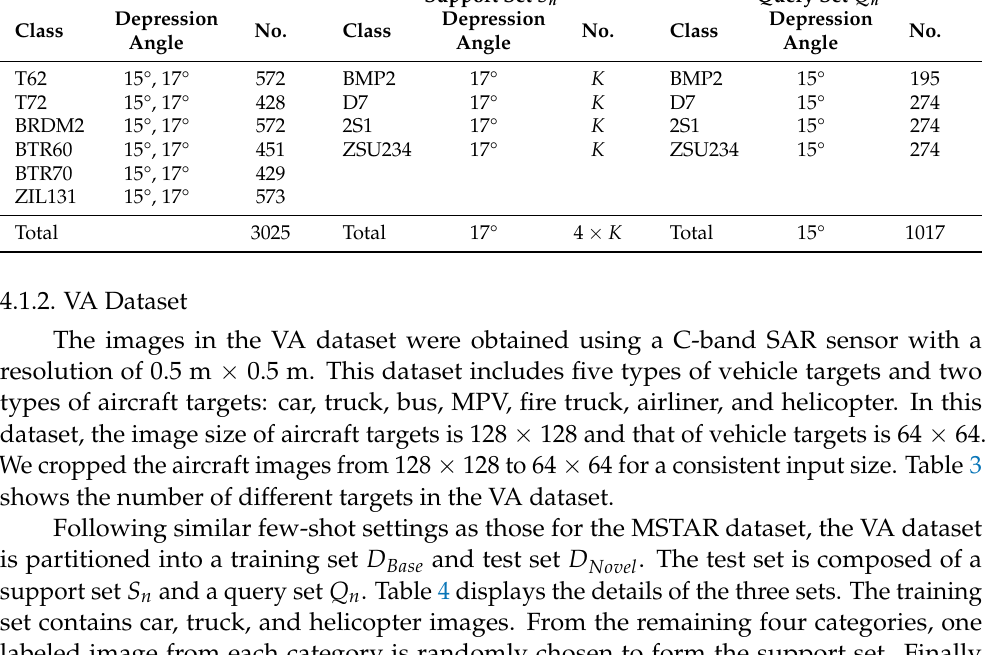
Table 2. The number of images in the training, support, and query sets of the MSTAR dataset. Training Set D